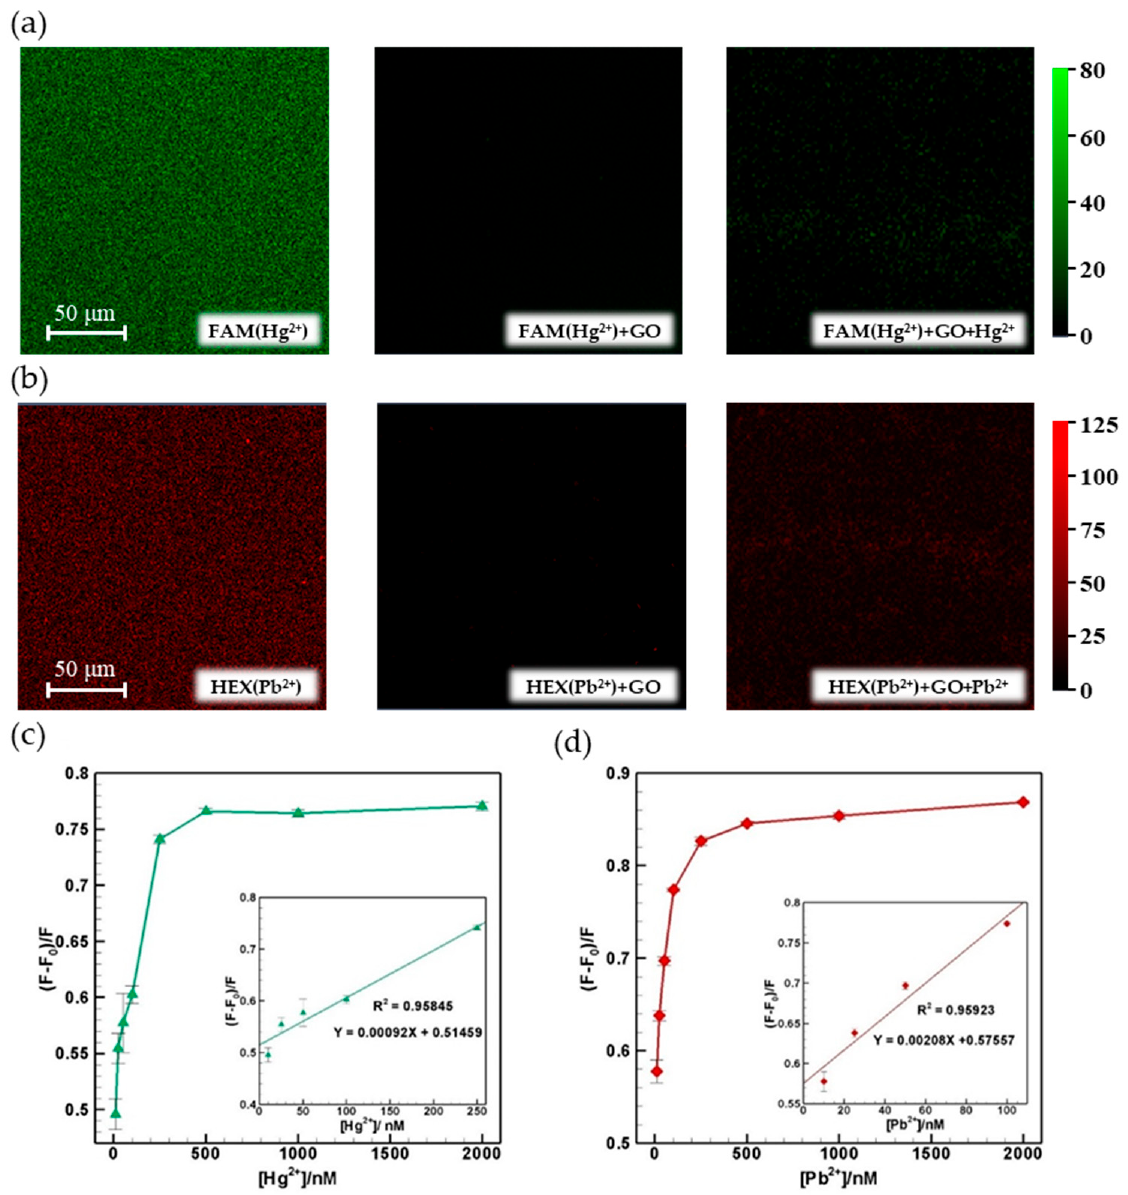
Figure 5. ( a ) Fluorescence images of FAM(Hg 2+ )-labeled probes and ( b ) fluorescence images of HEX(Pb 2+ )-labeled probes. The left, center and right images are the origin probes, quenched probes and probes restored by the target ion, respectively. The images were captured by a scanning laser confocal microscope using 20 × magnification. ( c ) Fluorescence intensity recovery following mixing with Hg 2+ solutions with concentrations ranging from 10 to 2000 nM (500 ppm GO). Insert: calibration curve for Hg 2+ solutions with concentrations ranging from 10 to 250 nM, and ( d ) fluorescence intensity recovery following mixing with Pb 2+ solutions with concentrations ranging from 10 to 2000 nM (500 ppm GO). Insert: calibration curve for Pb 2+ solutions with concentrations ranging from 10 to 100 nM.